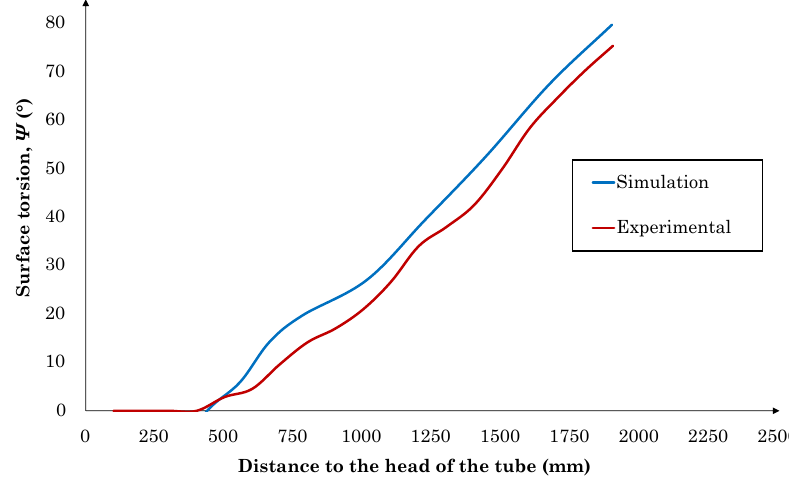
Figure 11. Comparison of the longitudinal torsion of the